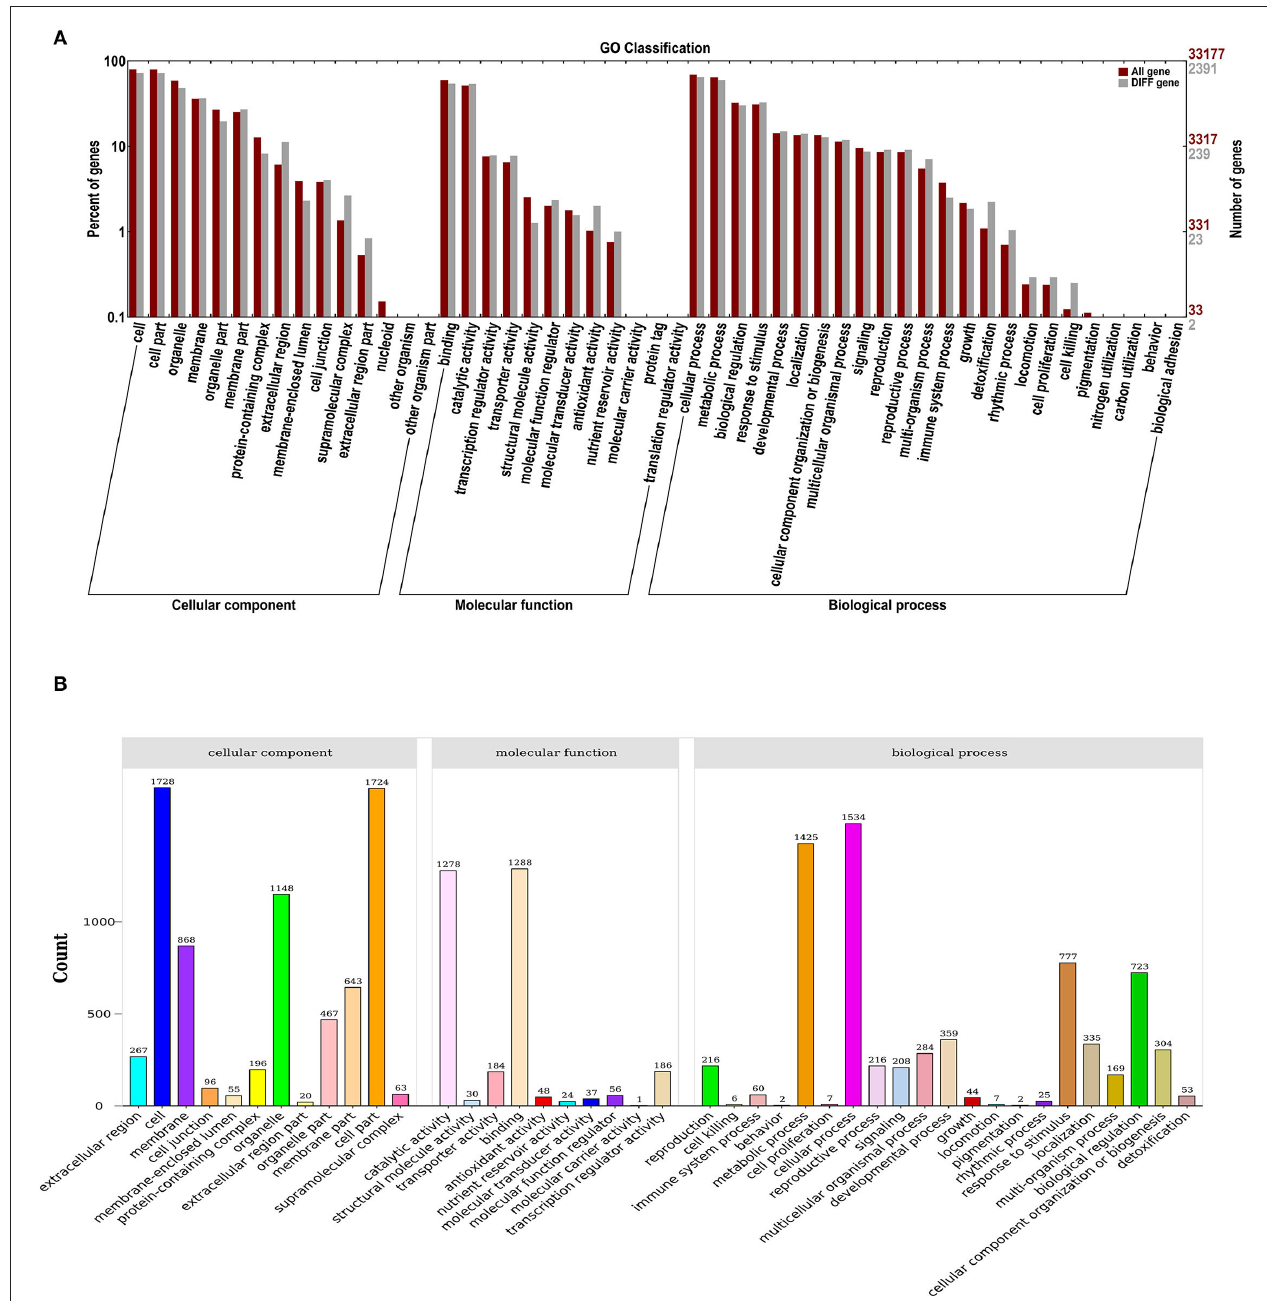
FIGURE 2 | GO enrichment analysis (A) and statistical classification analysis (B) of differentially expressed